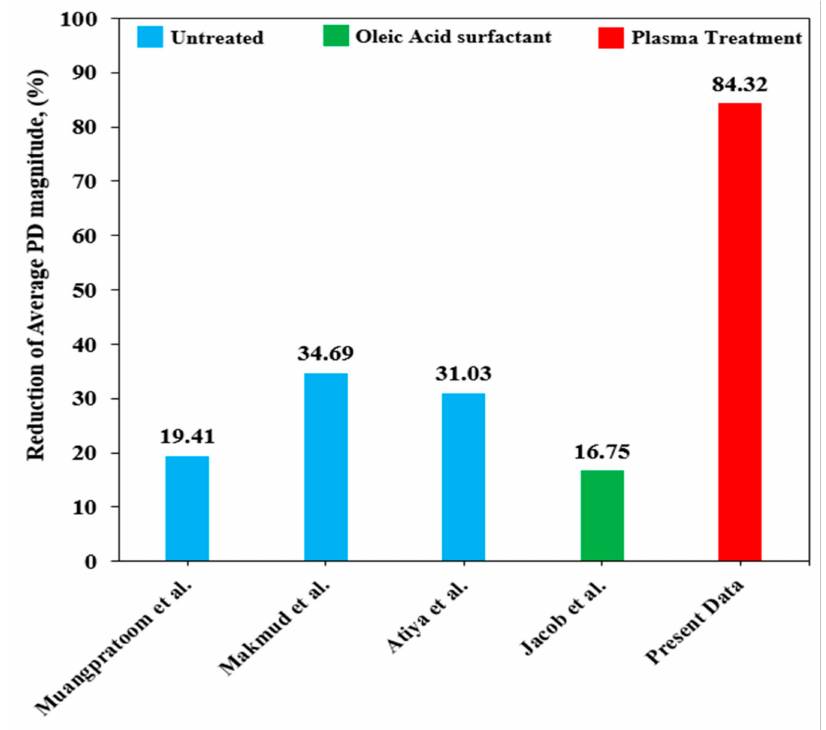
Figure 14. Comparison of the present experimental data of average PD magnitude with previous findings.